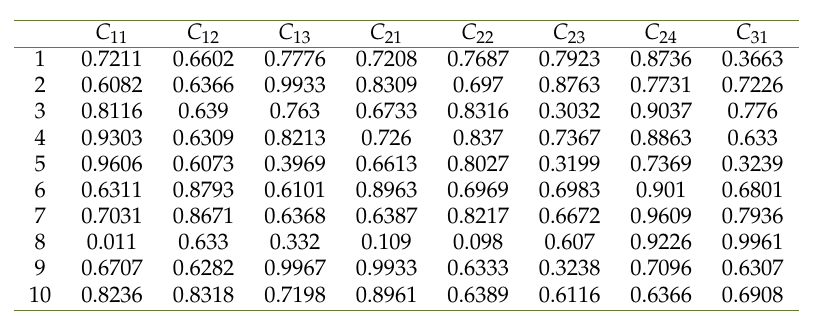
Table 4. THE NORMALIZATION DATA OF THE 20 PRIMARY AND SECONDARY SCHOOL EDUCATION